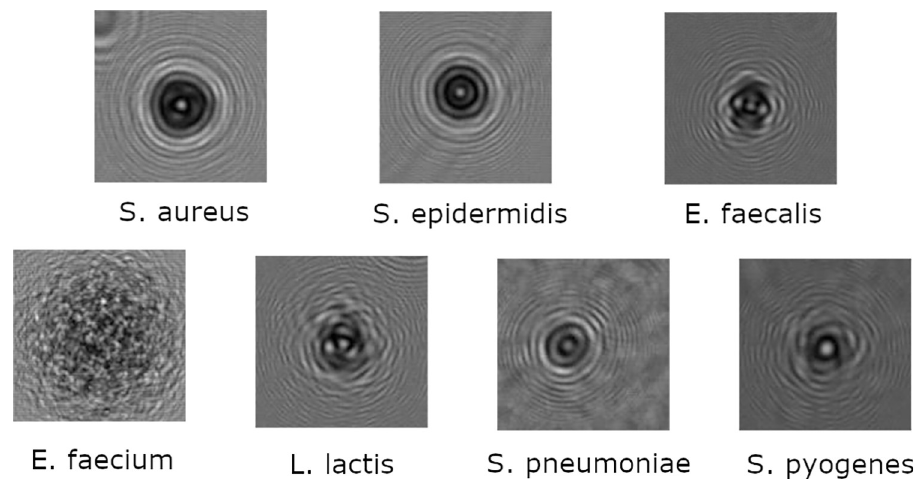
Fig 1. Bacteria Holograms. Holographic pattern of 7 bacteria strains after 12 hours of incubation at 37˚C on Brain Heart Infusion (BHI) agar.